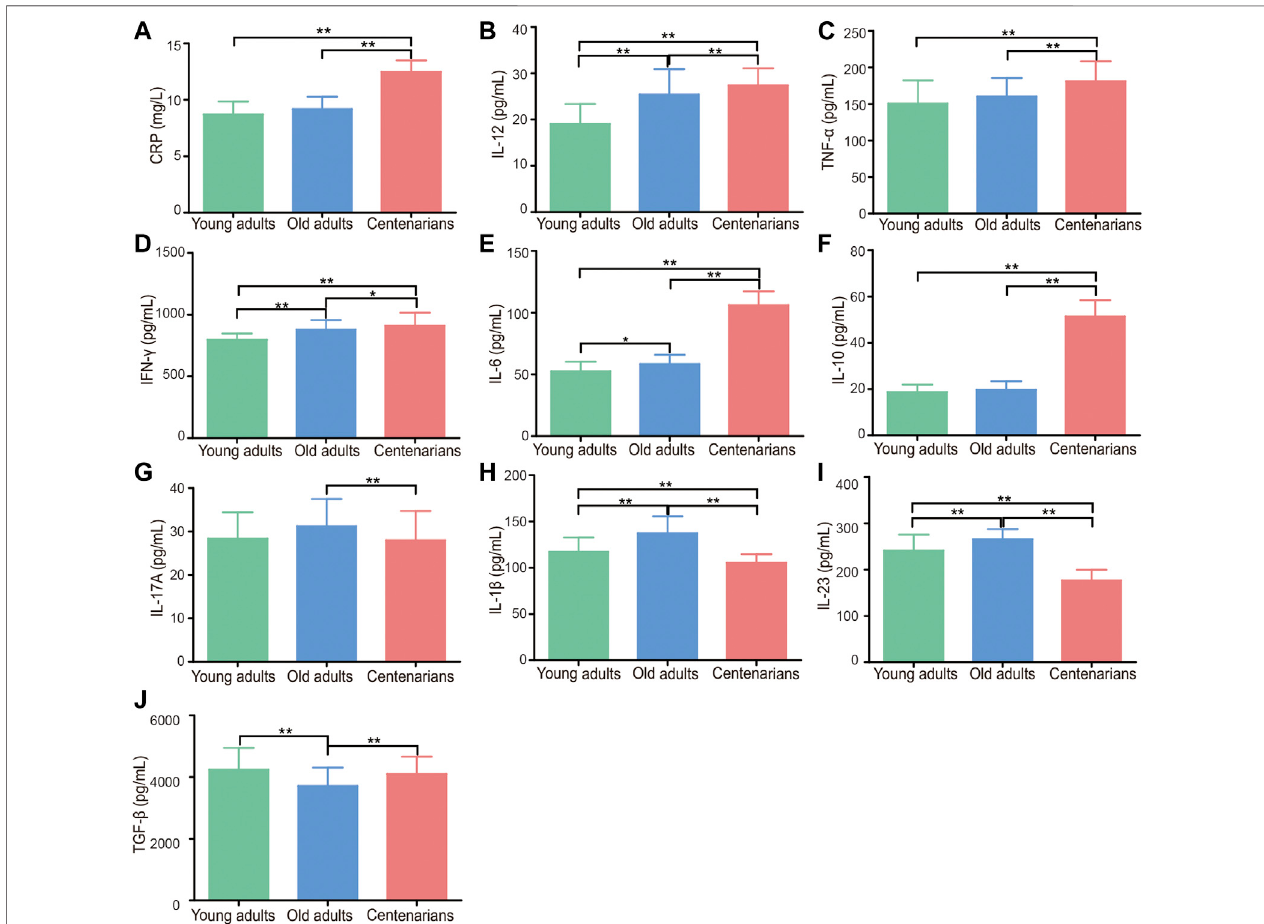
FIGURE1| Centenarianshaveuniquelevelsofin fl ammation-relatedfactors.In fl ammatorycytokinesandmediatorsinhumanplasma,includingCRP (A) ,IL-12 (B) , TNF- α (C) ,IFN- γ (D) ,IL-6 (E) ,IL-10 (F) ,IL-17A (G) ,IL-1 β (H) ,IL-23 (I) andTGF- β (J) ,weredetectedbyELISA.n=16,104or218,respectively.Datawereexpressedas the mean ± SD. Asterisks (*) indicate signi fi cant differences (* p < 0.05; ** p < 0.01).